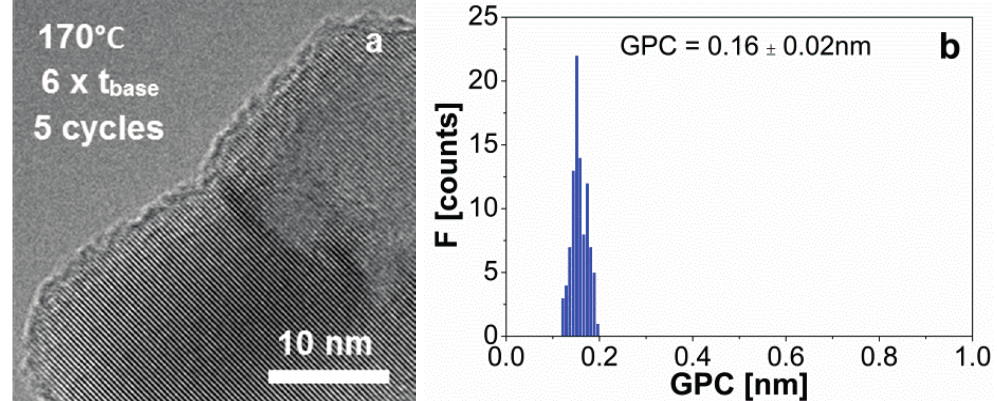
Figure 5. ( a ) TEM image of the alumina film on TiO 2 nanoparticles after 5 ALD cycles for a dosing sequence of 21–10–15–10 min at 1 bar and 170 °C; ( b ) The distribution of the GPC obtained from TEM images for a dosing sequence of time of 21–10–15–10 min